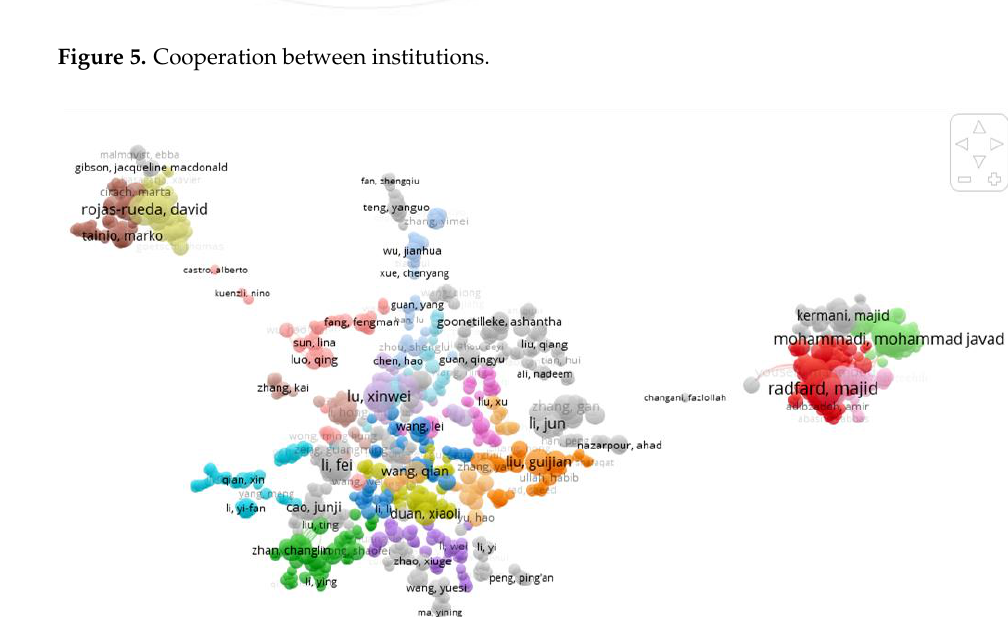
Figure 6. Collaboration between authors.